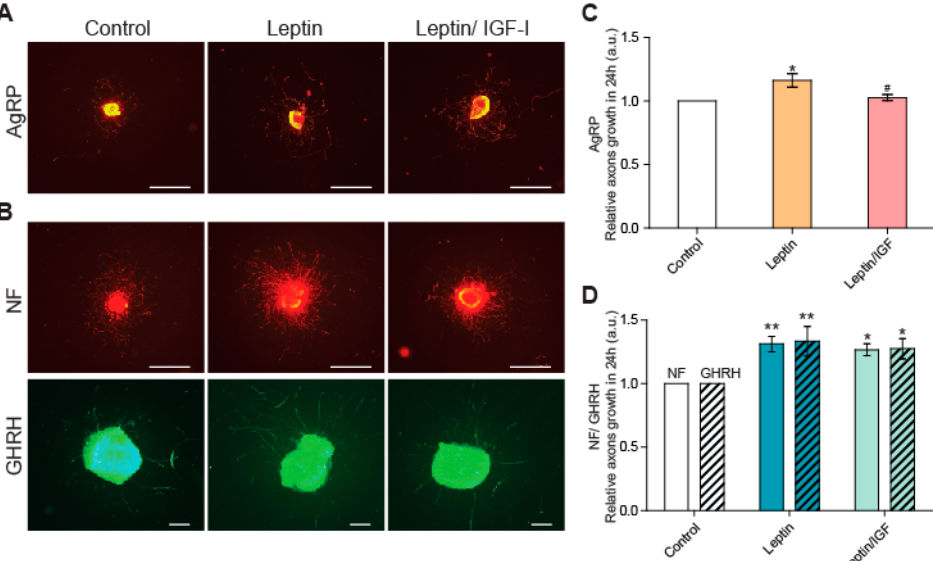
Figure 2. Leptin stimulates axon growth in GHRH neurons in arcuate nucleus explants from normally fed pups. ( A ) Illustrative IHC of AgRP neurons from arcuate nucleus explants micro-dissected from one-week-old normally fed pups, in control conditions (left panels), and after stimulation with leptin (middle panels) and with leptin/IGF-1 (right panels). ( B ) Illustrative images of dual IHC for the axons of total arcuate nucleus neurons labeled with NF (top panels in red) and GHRH neurons labeled with eGFP (bottom panels in green), in the same conditions. Scale bars represent 1000 µm for AgRP+ and NF+ IHC (4X magnification) and 200 µm for GHRH+ IHC (10X magnification), for images from a BX612 Olympus fluorescence microscope equipped with a DP71 CCD camera. ( C ) Quantification of the growth of AgRP axons after 24 h of stimulation with leptin or leptin/IGF-I relative to control conditions ( n = 4 experiments), and ( D ) of the growth of NF (plain bars) and GHRH (dashed bars) axons ( n = 5–7 experiments). Data are presented as the mean ± SEM. Results were compared in a one-way ANOVA with the Newman–Keuls post hoc test (c) or a two-way ANOVA with Bonferroni correction (d), with *: p < 0.05 and **: p < 0.01 vs. control condi- tions and #: p < 0.05 vs. leptin stimulation. All the neurons of the arcuate nuclei were labeled with an antibody directed against the ubiquitously expressed neurofilament protein (NF), and a stimulatory effect of leptin was visible in the total neuron populations of arcuate nuclei (Figure 2B,D). Treatment with leptin for 24 h resulted in arcuate neuron axons that were 1.31 ± 0.07 times longer than those observed in control conditions: 484 ± 45 µm for control conditions and 628 ± 49 µm following leptin treatment ( n = 7 experiments, p < 0.01). We then looked at the specific effects of leptin on axon growth in the subpopulation of GHRH neurons. In the explants used for the NF analysis described above, we found that Ghrh-eGFP+ axons treated with leptin were 1.33 ± 0.13 times longer than control axons: 385 ± 27 µm in control conditions and 510 ± 47 µm after leptin treatment ( n = 5 experiments, p < 0.01) (Figure 2B,D). These results suggest that leptin levels may directly regulate the development of GHRH neu- rons. We previously showed that IGF-1 selectively stimulates axon growth in GHRH neurons [19]. We therefore investigated the possible synergy between leptin and IGF-1. The treatment of arcuate nucleus explants with both leptin and IGF-I for 24 h did not lead